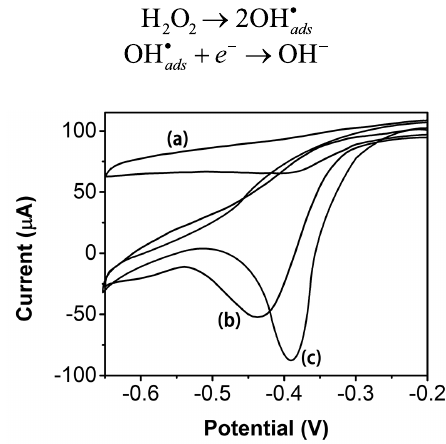
FIGURE 4 - Cyclic voltammetry results of (a) GCE, (b) C-ZnO/ GCE and (c) B-ZnO/GCE towards the detection 0.05 mM H in PBS solution. Scan rate: 50